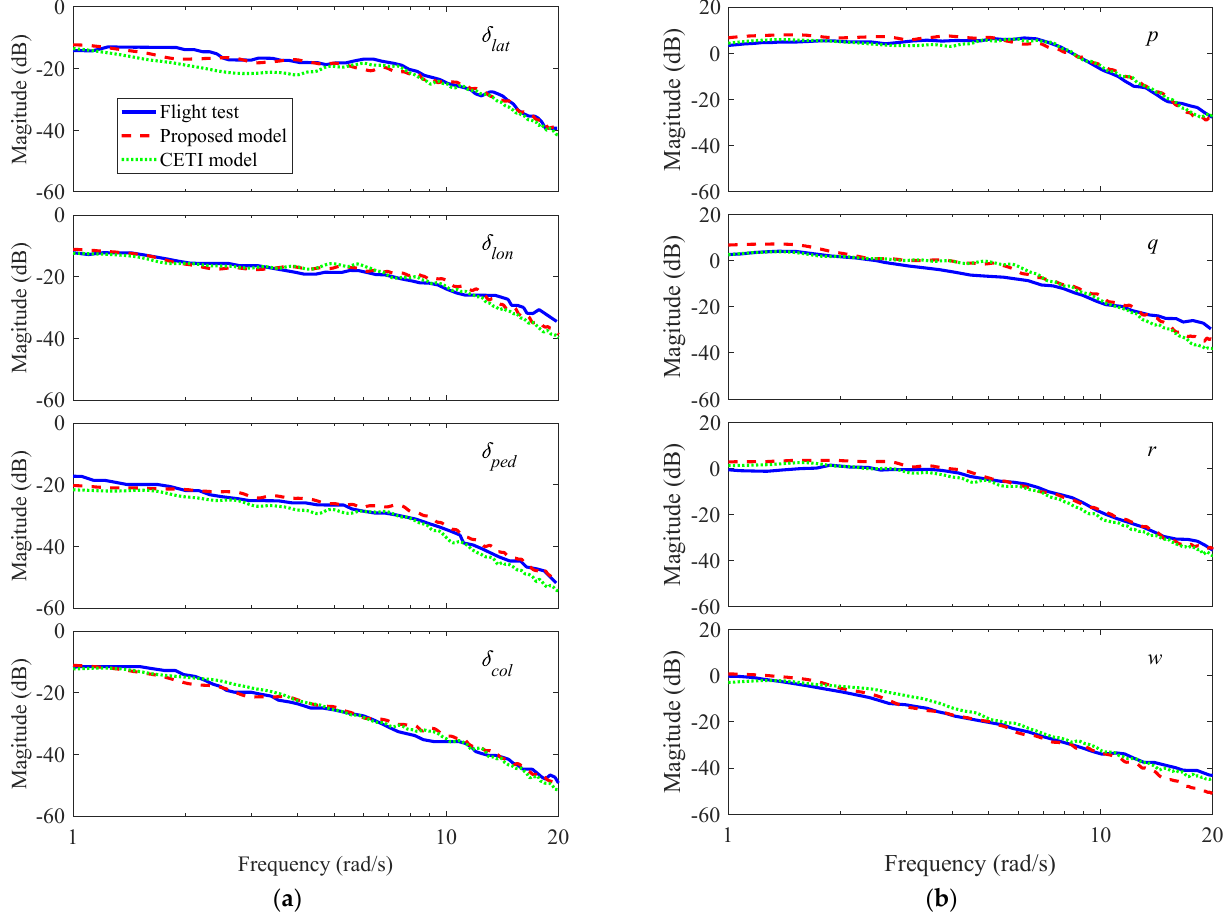
Figure 12. Comparison of simulated pilot controls and rotorcraft responses in turbulence against flight test data. ( a ) Pilot controls; ( b ) Rotorcraft responses.